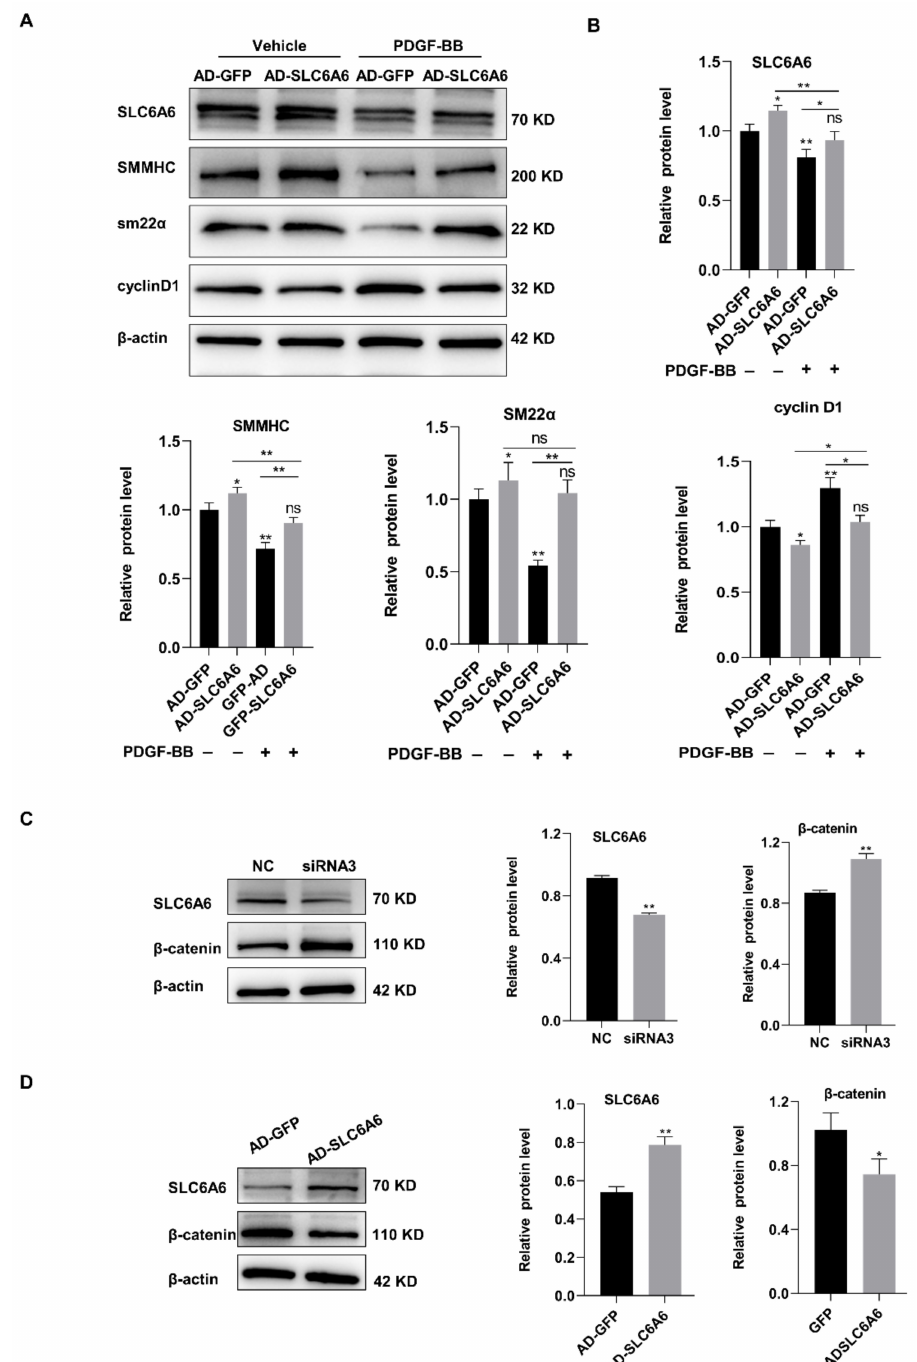
Figure 6. SLC6A6 regulated VSMC functions via β ‑catenin signaling. ( A , B ) Western blot analysis of SLC6A6 and contractile VSMC‑specific proteins (SMMHC, SM22 α ) and cells proliferation marker cyclin D1 after infecting VSMCs with AD‑GFP or AD‑SLC6A6 for 24 h with or without PDGF‑BB (50 ng/mL) for another 24 h, respectively. Data are normalized to β ‑actin; N = 3; * p < 0.05, ** p < 0.01; ns, not significant; data are represented as mean ± SD. ( C ) Western blot analysis of SLC6A6 and β ‑ catenin proteins in VSMCs after transfection with normal control (NC) or siRNA 3 (siRNA‑SLC6A6). Data are normalized to β ‑actin; N = 3; * p < 0.05, ** p < 0.01 vs. NC; data are represented as mean ± SD. ( D ) Western blot analysis of SLC6A6 and β ‑catenin protein levels in VSMCs after infection with AD‑ GFP or AD‑SLC6A6. Data are normalized to β ‑actin; N = 3; * p < 0.05, ** p < 0.01 vs. AD‑GFP; data are represented as mean ±